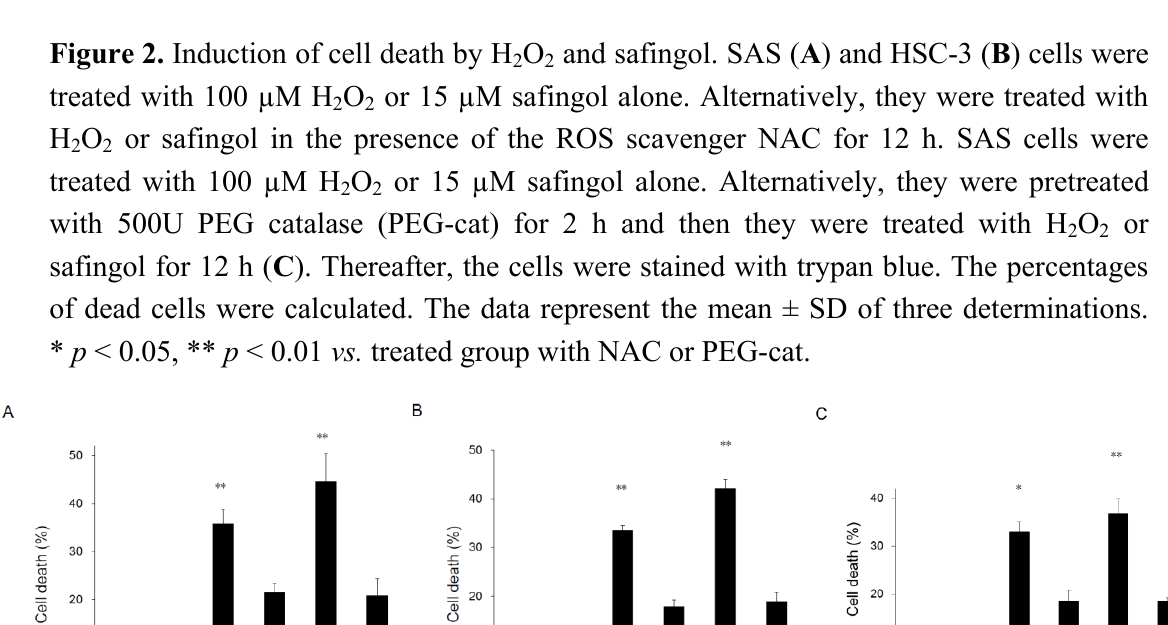
O and safingol. SAS cells were treated 2 2